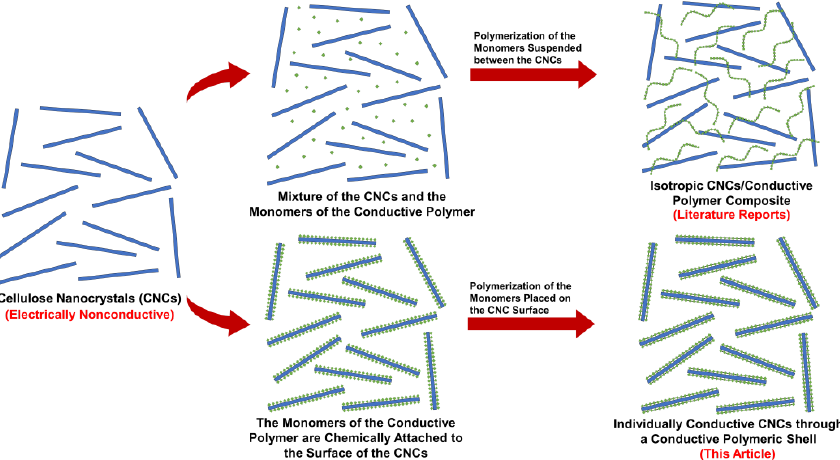
Figure 1. The uniqueness of the electrically conductive CNCs prepared in this article compared to those in the literature [22,23].